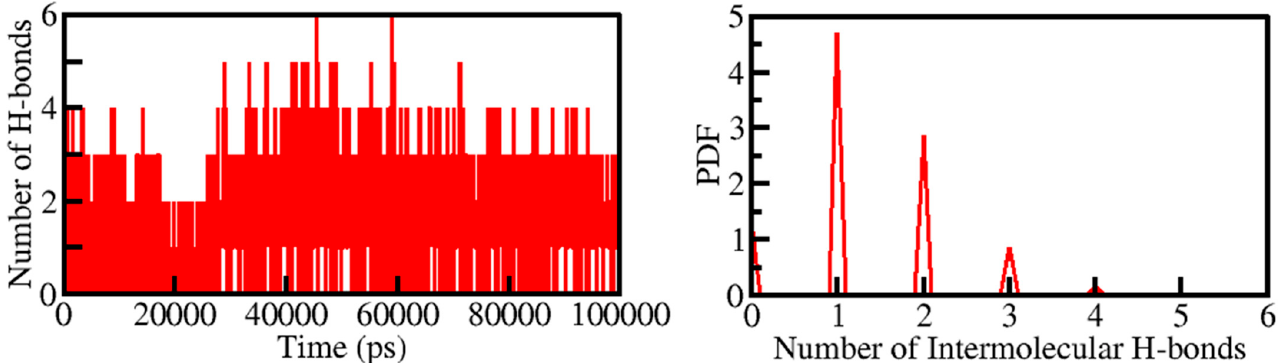
Figure 5. Time evolution of intermolecular H-bonds formed within 0.35 nm between Tuberosin and PKM2 (Left panel). The right panel shows the PDF of the intermolecular H-bonds between Tuberosin and PKM2.